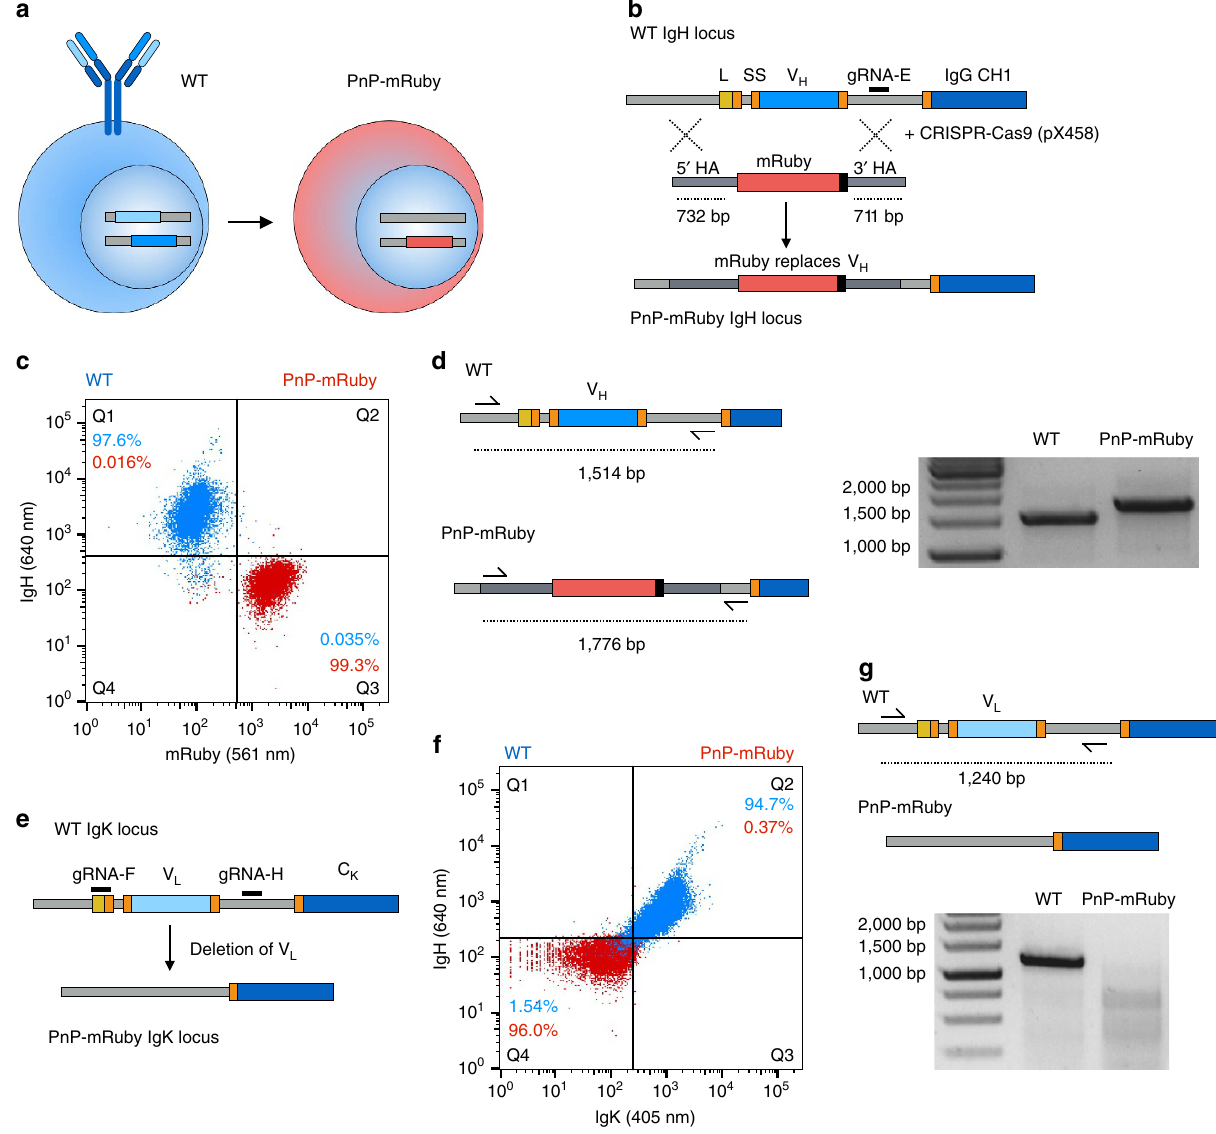
Figure 1 | Generation of plug-and-(dis)play-mRuby cells. ( a ) Schematic shows wild-type (WT) hybridoma cells expressing antibody that will be converted into plug-and-(dis)play (PnP)-mRuby cells. ( b ) Shown is the targeting of WT IgH genomic locus with the following annotations: leader sequence (L, yellow), mRNA splice sites (SS, orange), V H (blue) and IgG constant heavy region (C H 1, dark blue). The Cas9 gRNA-E target site (black) is in the intron between V H and C H 1. The donor construct consists of mRuby gene with a stop codon flanked by two homology arms (HA) of 732 and 711bp. The PnP- mRuby IgH locus is generated by electroporation of WTcells with CRISPR-Cas9 plasmid and donor construct, which will result in HDR-based exchange of the V H region with mRuby. ( c ) Flow cytometry dot plot shows that WTcells are exclusively IgH-positive and mRuby-negative, where PnP-mRuby cells are exclusively mRuby-positive and IgH-negative. ( d ) PCR was performed on genomic DNA from WTand PnP-mRuby cells using a forward primer in 5 0 HA and reverse primer that is external of the 3 0 HA. Agarose gel shows the expected size of bands. The band from PnP-mRuby cells was extracted and Sanger sequencing confirmed mRuby exchange of the V H region (see Supplementary Fig. 3). ( e ) Shown is the targeting of WT hybridoma IgK locus with the following annotations: V L (light blue), and IgK constant light region (C K , dark blue), other annotations same as shown in a . Two gRNA target sites (black) are utilized to delete the V L region. ( f ) Flow cytometry dot plot shows WT cells are strongly IgH-positive and IgK-positive, where PnP-mRuby cells are exclusively IgH-negative and IgK-negative. ( g ) PCR was performed on genomic DNA from WTand PnP-mRuby cells using a forward primer 5 0 of the gRNA- F site and reverse primer 3 0 of gRNA-H site. Agarose gel shows the expected size of band for WT cells and nearly no amplification product for the PnP-mRuby cell line. Throughout this figure, WT cells correspond to clone WEN1.3 and PnP-mRuby cells correspond to clone 1E9.C3 (for more details, see Supplementary Table